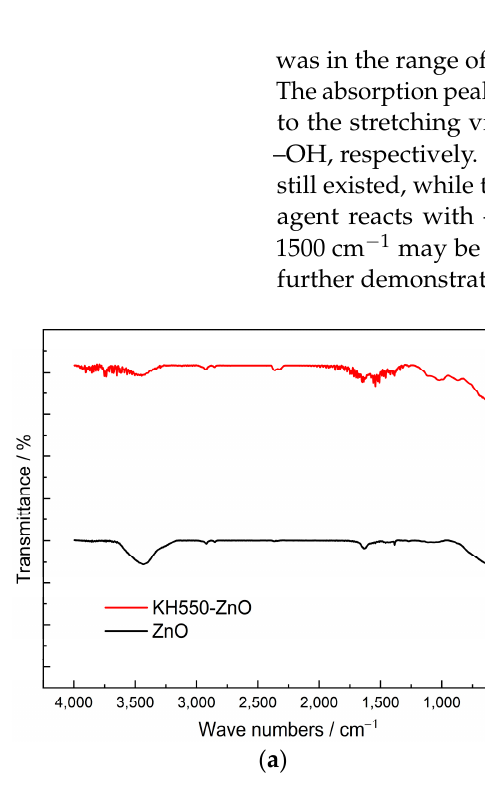
Figure 5. Infrared spectrum of ZnO/PI and PI films. ( a ) Untreated ZnO and KH550-ZnO; ( b ) original PI and commercial Kapton film.